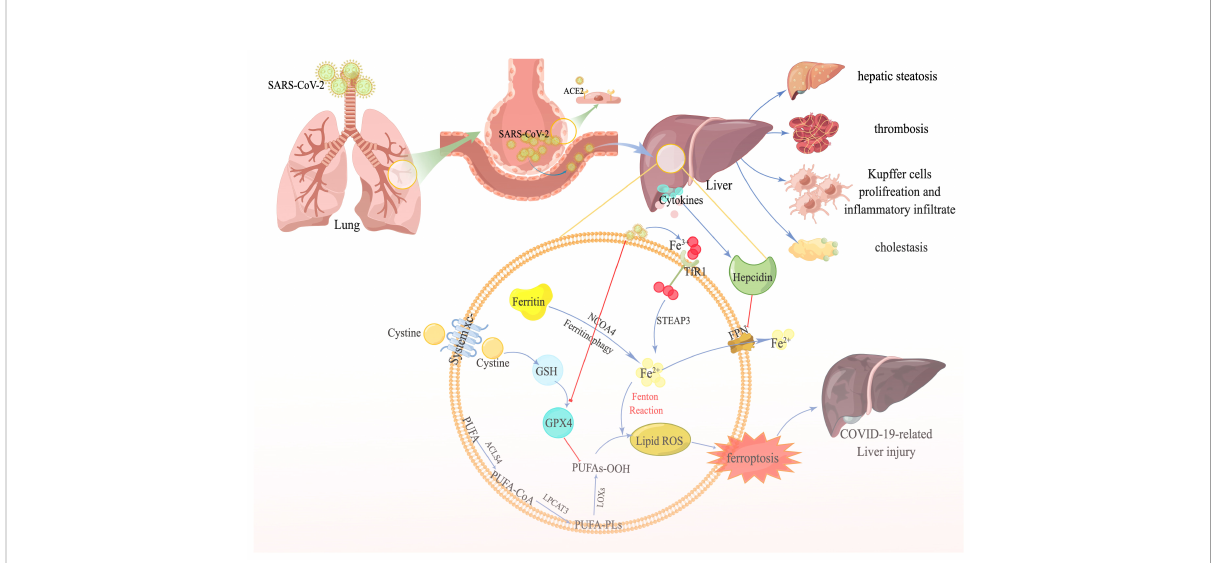
FIGURE 1 The potential link between ferroptosis and COVID-19-related liver injury. SARS-CoV-2 recognizes the angiotensin-converting enzyme 2 receptor in the alveoli, especially type II alveolar cells. SARS-CoV-2 subsequently reaches the blood circulation through the damaged blood – air barrier. Next, SARS-CoV-2 further infects the liver. After the infection, a plethora of transferrins carrying Fe 3+ is transferred into the cell through transferrin receptor1. Eventually, Fe 3+ is transformed to Fe 2+ by STEAP family member 3, in addition to the Fe 2+ degraded from excessive ferritin by nuclear receptor coactivator 4 — contributing to the accumulation of ferrous iron in the cell. Numerous cytokines are also released during the infection, stimulating hepcidin expression, suppressing ferroportin, and aggravating the accumulation of iron even more. On the other hand, SARS-CoV-2 decreases the expression of GPX4, facilitating the iron overload-induced Fenton reaction, accompanied by polyunsaturated fatty acids, and producing massive amounts of lipid reactive oxygen species. Ultimately, ferroptosis occurs and causes liver